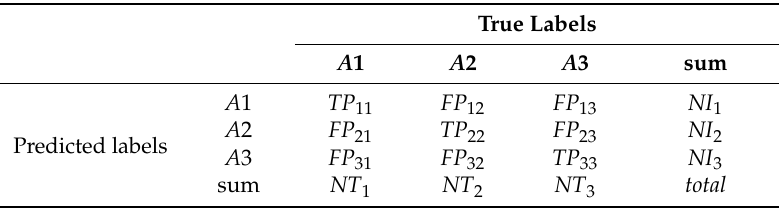
Table 4. Confusion matrix for the classification of three human